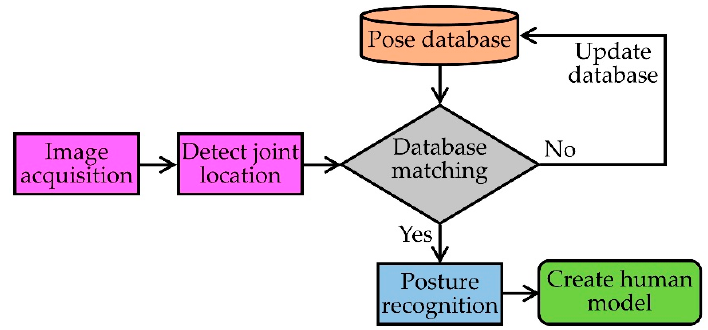
( b ) Figure 7. ( a ) Sensing setup of optical-based goniometer system for human elbow joint measurement; ( b ) operation method of the system. 3.2. Imaging and Video-Based Tracking System Imaging and video-based human skeletal tracking is a well-accepted method for human joint monitoring because of its broad applicability and reliability [31,32,34–36,101–107]. One or more cameras are the core components of this system. The process flow of this method is to capture the visual data of several human actions by using a single [34] or multiple camera network [32], and then track the joints using anthropometric constraints (size, shape and composition of the human body)